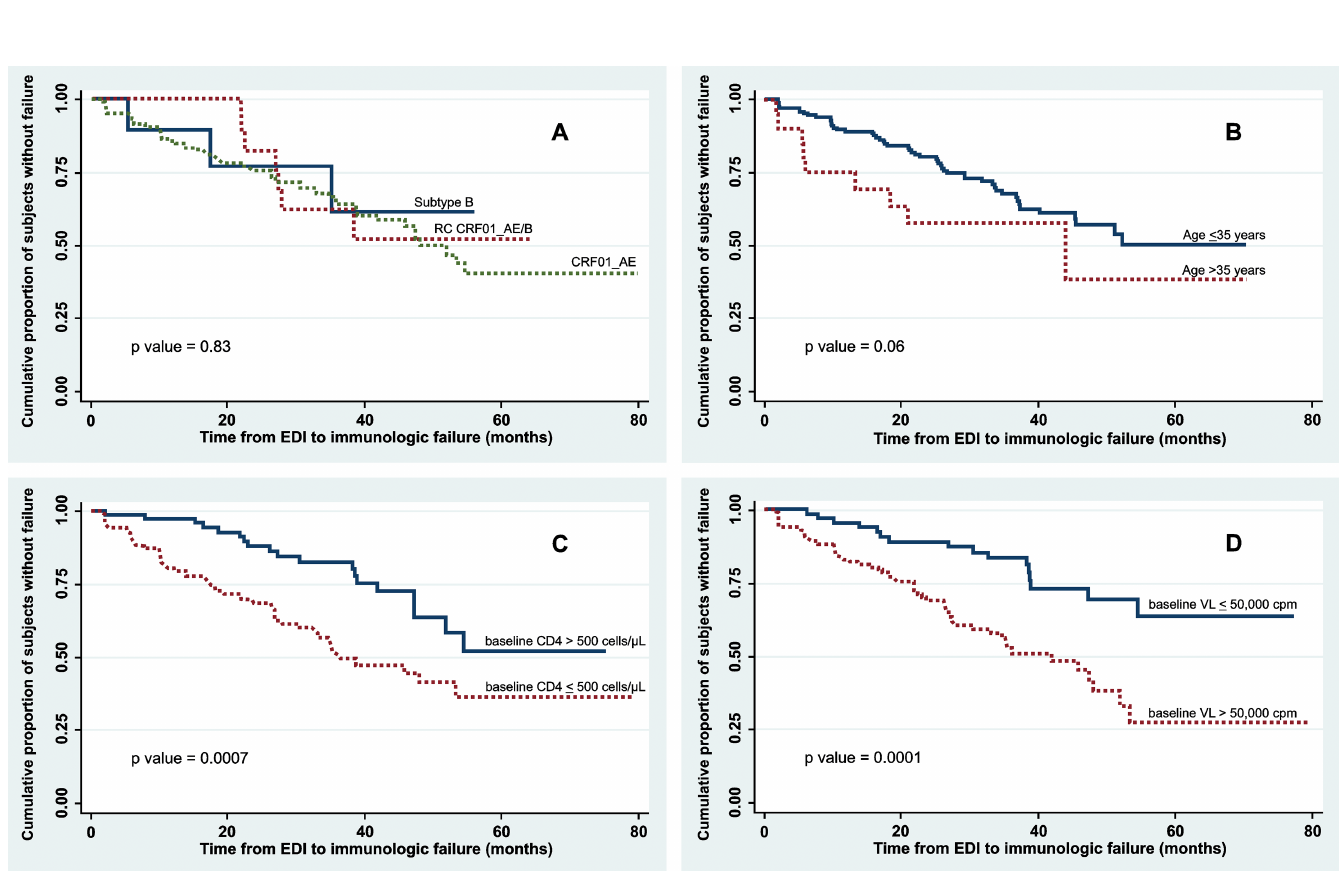
Fig 1. Kaplan-Meier survival curves. (A) Time to immunologic failure by infecting HIV subtype; (B) Time to immunologic failure by age at HIV conversion; (C) Time to immunologic failure by baseline CD4+ cell counts; (D) Time to immunologic failure by baseline viral load.